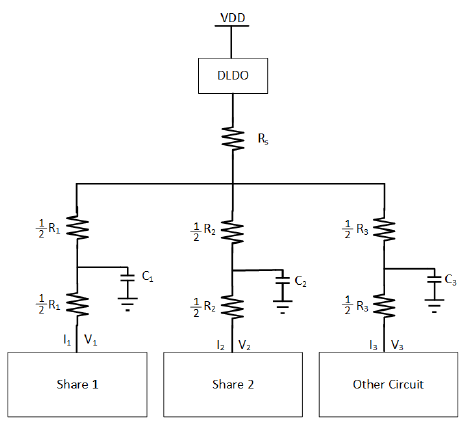
Figure 15. PDN, masking shares, and other circuitry with a single